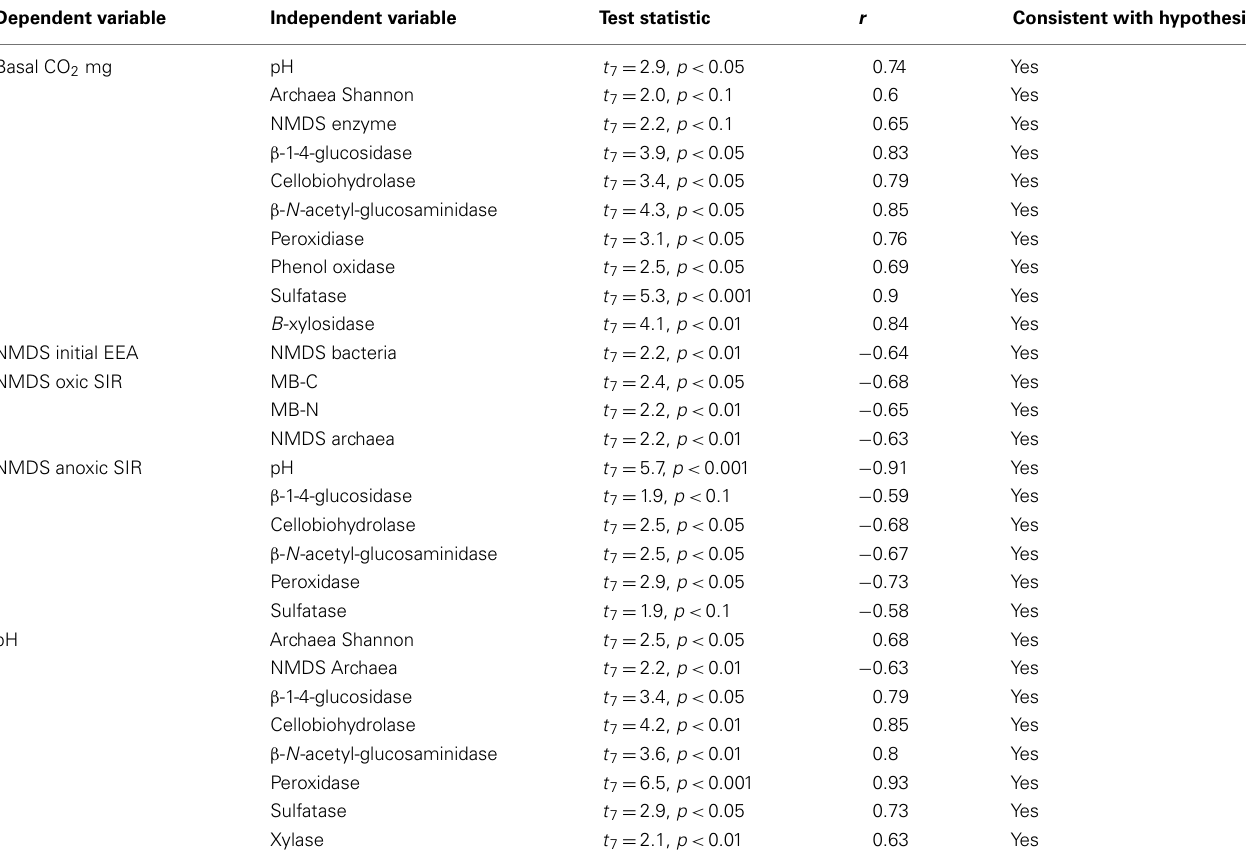
Table 4 | Pearson’s product moment correlations between measures of microbial activity/pH and potential explanatory